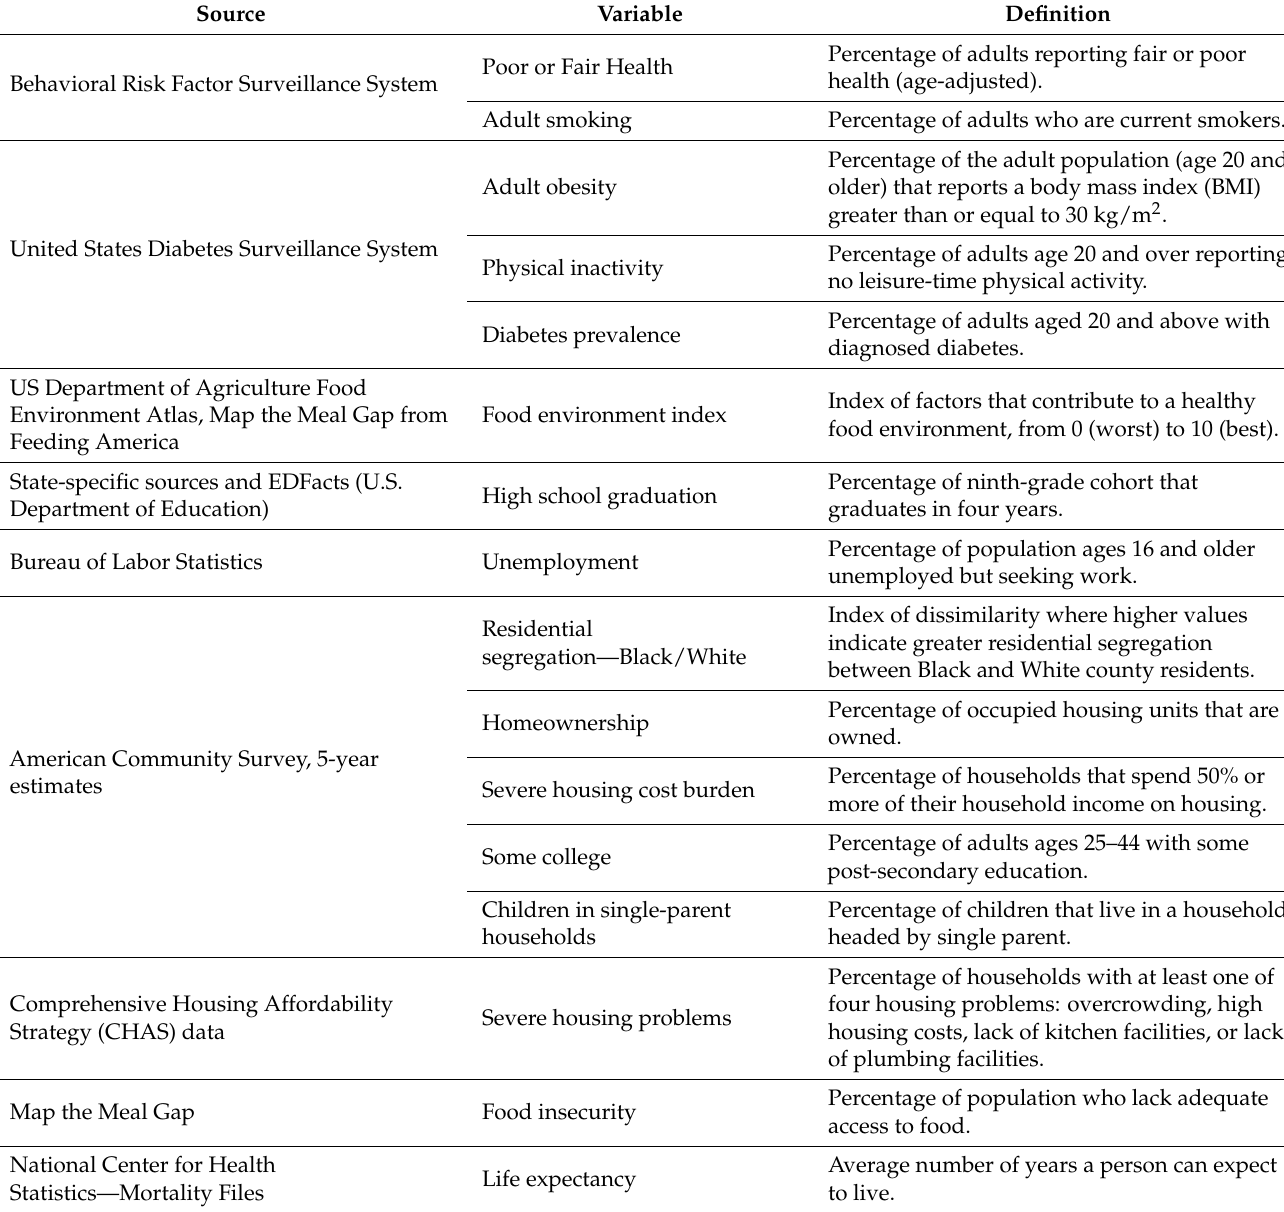
Table A1. Sources for county-level